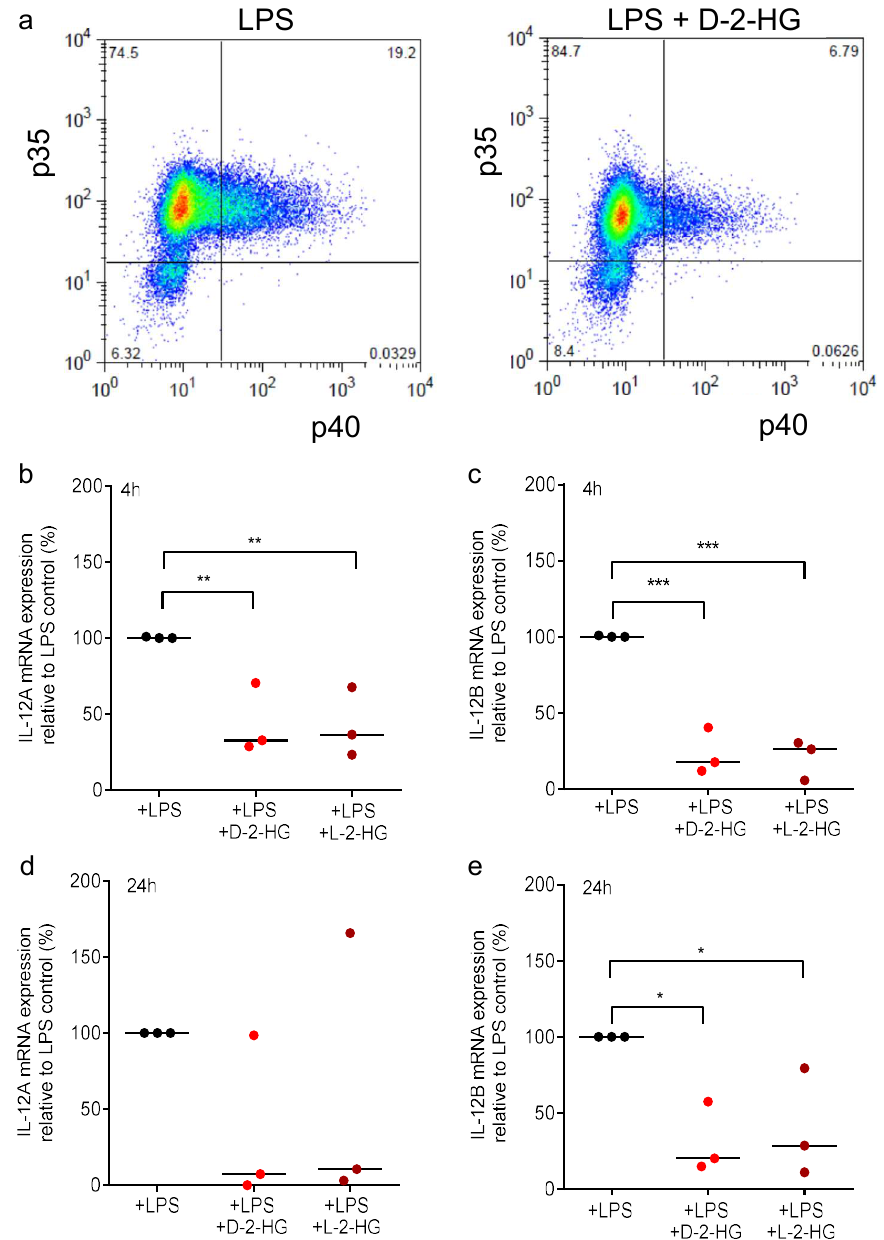
Figure 3. D-2-HG reduces intracellular IL-12 levels and mRNA expression in DCs. ( a ) Monocyte-derived immature dendritic cells (iDCs) were activated with 100 ng/mL LPS with or without D-2-HG in the presence of monensin. Intracellular levels of IL-12 p35 and IL-12 p40 were analyzed by flow cytometry. One representative experiment out of three is shown. ( b , c ) Monocyte-derived iDCs were activated with 100 ng/mL LPS with or without D-2-HG or L-2-HG for 4 h ( b , c ) or 24 h ( d , e ). RNA was isolated from cell lysates. After reverse transcription, the samples were analyzed by RT-qPCR. Gene expression of IL-12p70 subunits IL-12A and IL-12B relative to 18S RNA are shown. Data represent the median of three independent experiments. Statistical analysis was tested using an Ordinary One-Way Test with Dunnet’s multiple comparison test (* p ≤ 0.05, ** p ≤ 0.01, *** p ≤ 0.001).